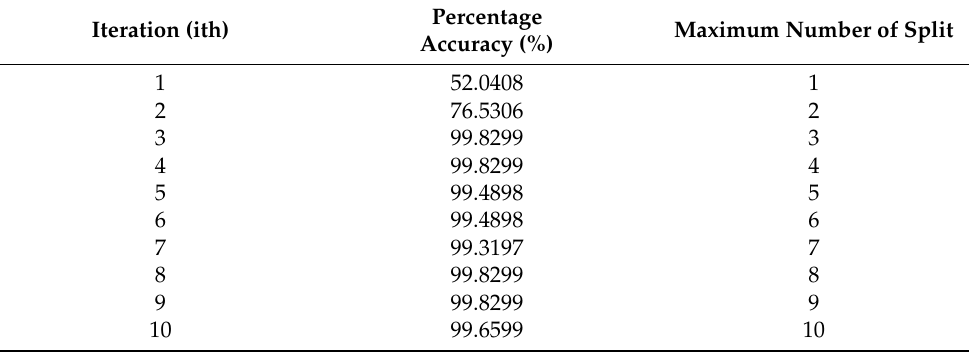
Table 7. Percentage accuracy for different maximum number of split set